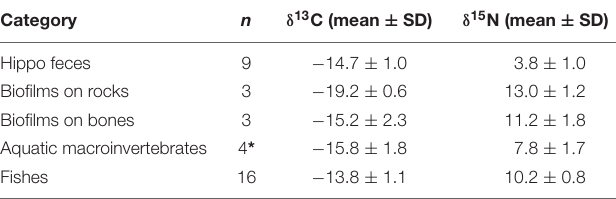
TABLE 2 | Stable isotope signatures of basal food web resources, aquatic macroinvertebrates, and fishes collected in February 2014, at the New Mara Bridge in the Mara